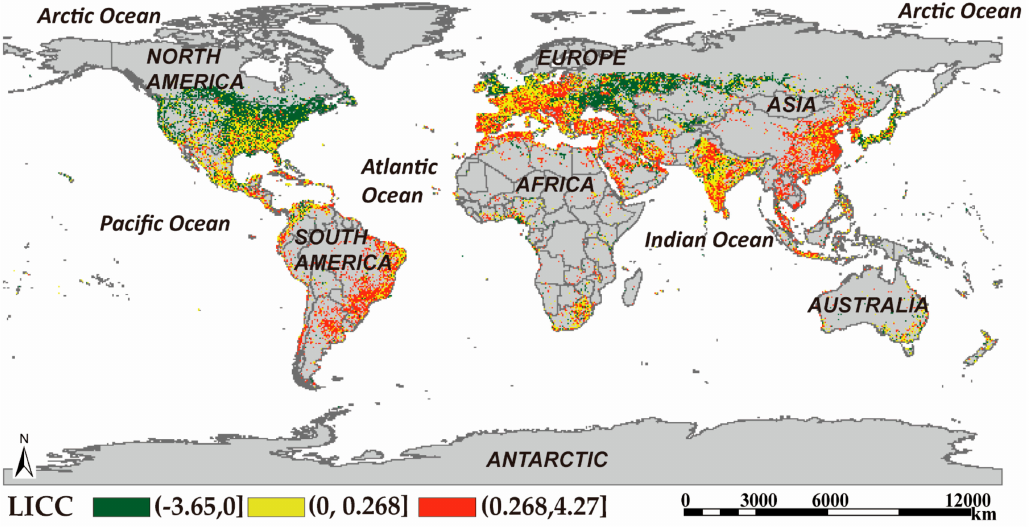
Figure 10. LICC of global stable lighting area from 1992 to